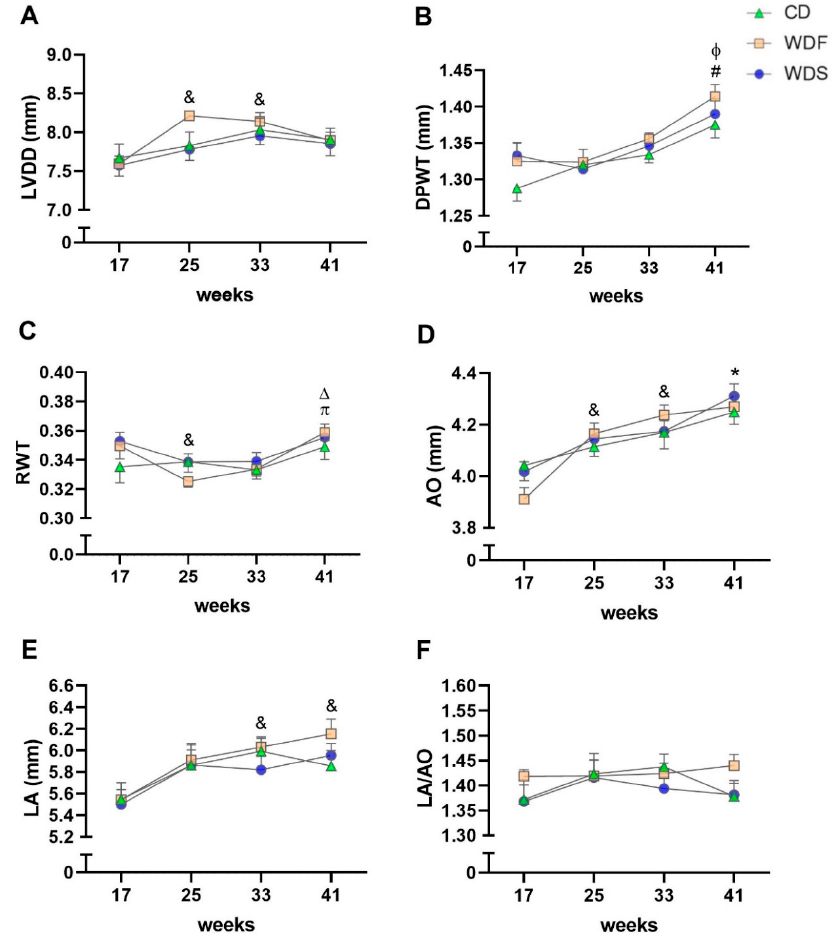
Figure 6. Serial echocardiographic structural assessment. The analysis was performed at the 17th, 25th, 33rd, and 41st week of dietary intervention with Control diet (CD), Western diet fat (WDF), and Western diet sugar (WDS). ( A ) Left ventricle (LV) diastolic diameter (LVDD). ( B ) LV diastolic posterior wall thickness (DPWT). ( C ) Relative wall thickness (RWT). ( D ) Aortic diameter (AO). ( E ) Left atrial diameter (LA). ( F ) LA / AO ratio. Data are presented as mean ± s.e.m. Two-way repeated-measures ANOVA and Bonferroni post hoc test. Symbols indicate differences between the moments fixed the group. & p < 0.05 vs. 17 weeks for WDF; Δ vs. 33 weeks for WDF; ɸ p < 0.01 vs. 25 weeks for WDF and WDS; * vs. 17 weeks for C, WDF, and WDS; # p < 0.001 vs. 17 weeks for C and WDF; π vs. 25 weeks for WDF (n = 10 per group).